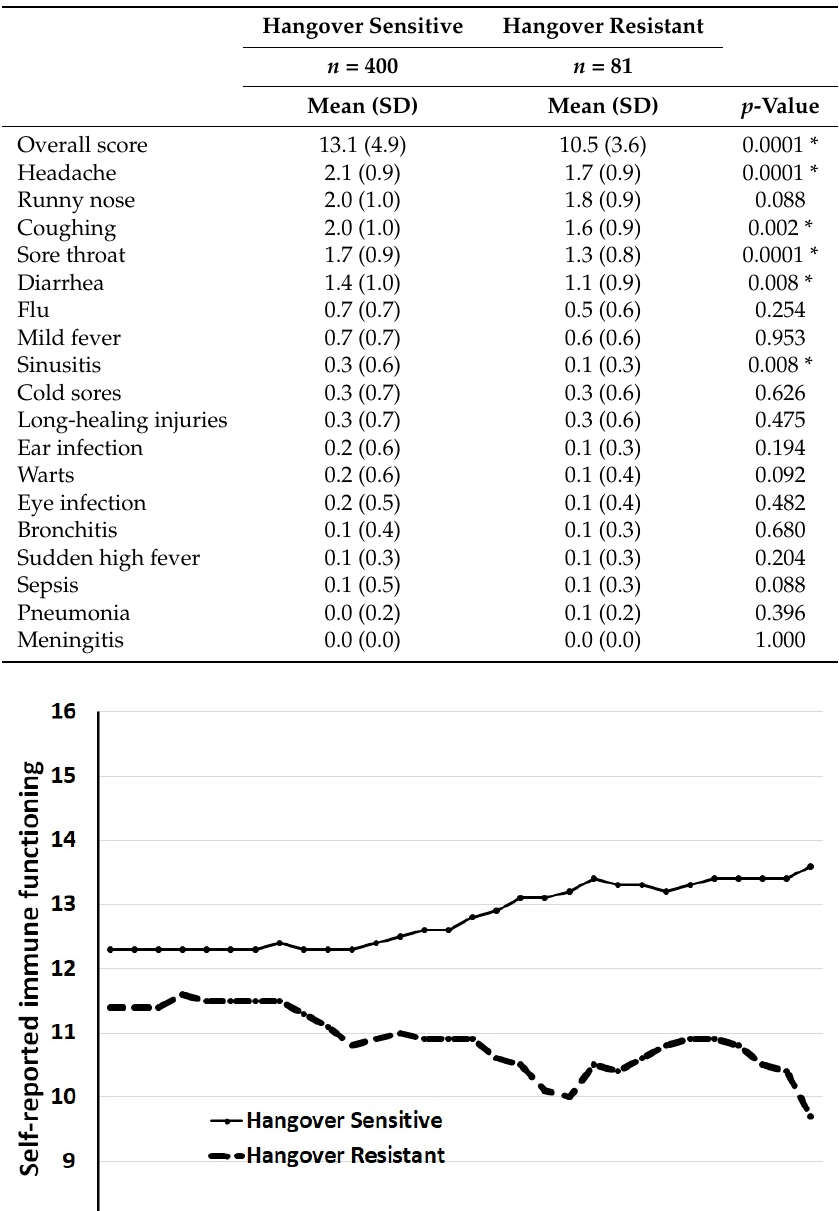
Table 2. Self-reported immune function of hangover-sensitive drinkers and hangover-resistant drinkers after achieving an estimated BAC of at least 0.18% during the heaviest drinking occasion in the prior month. Data was compared using an independent-sample Mann–Whitney U test. Significant differences ( p < 0.05) between the groups are indicated with *.